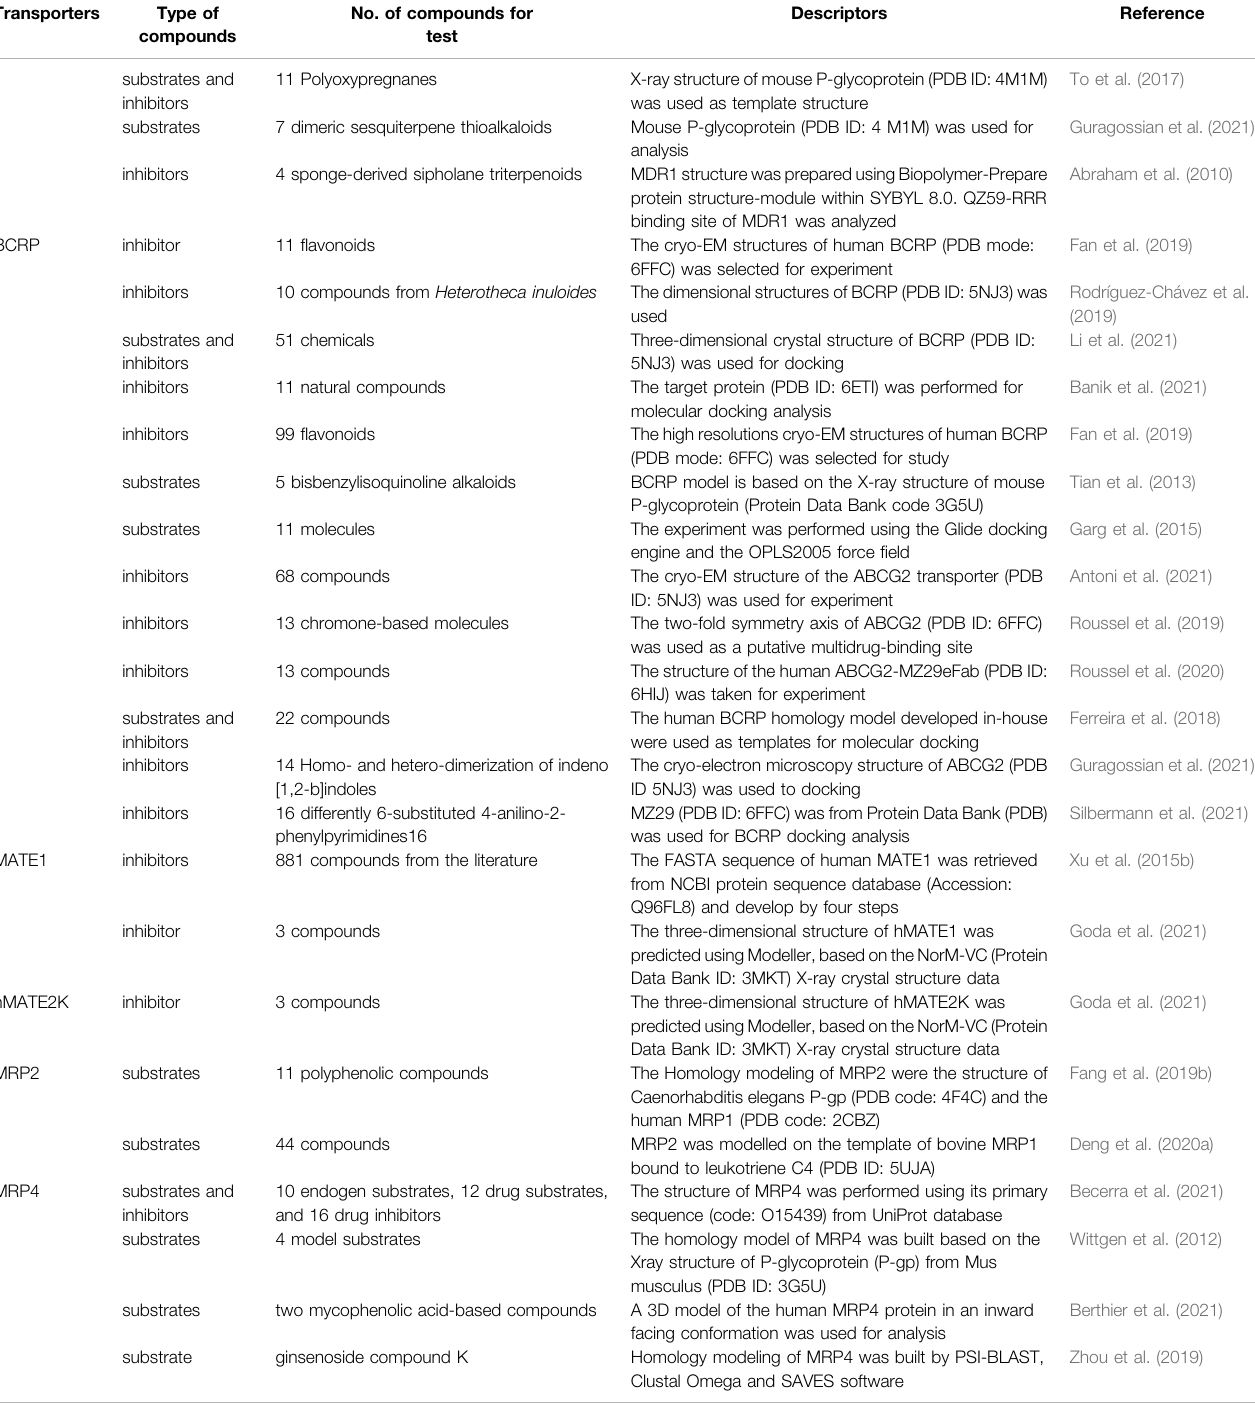
TABLE 6 | ( Continued ) Summary of published molecular docking models for assessing the substrates and inhibitors of drug